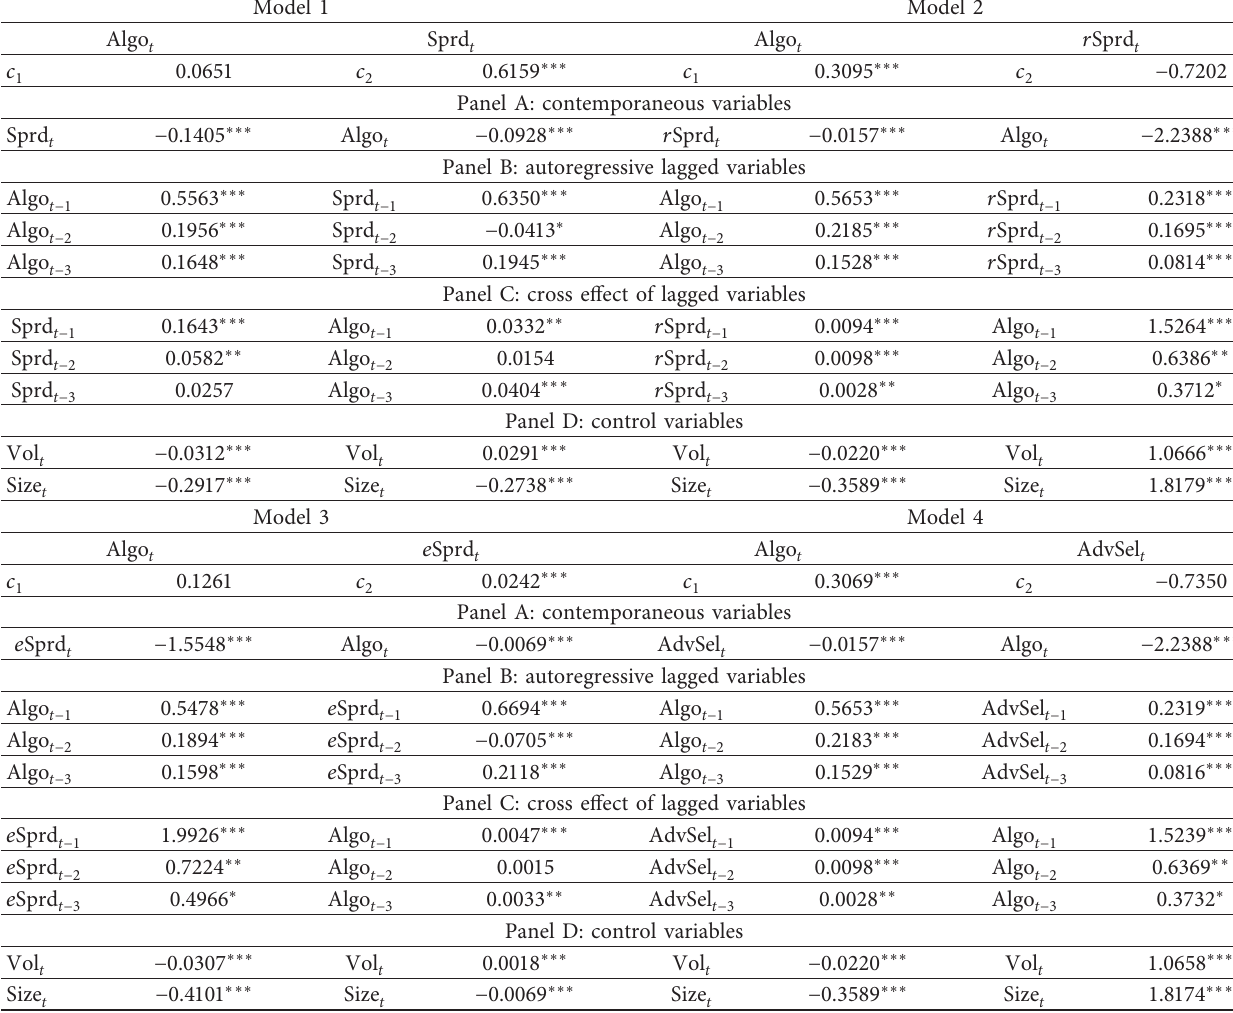
Table 4: Relationship between algorithmic trading and liquidity indicators (September 7, 2015–December 31, 2015, excluding opening and closing time